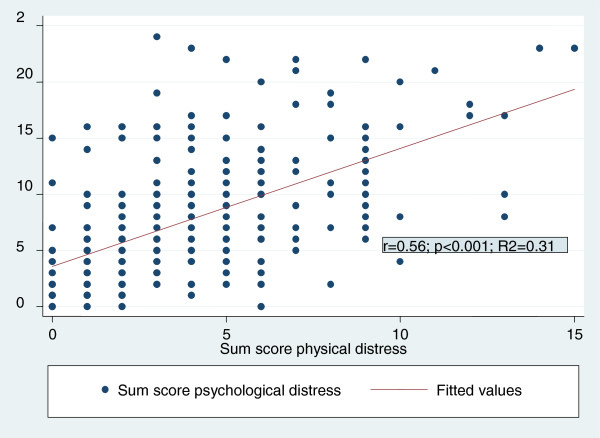
Association between physical and psychological distress.